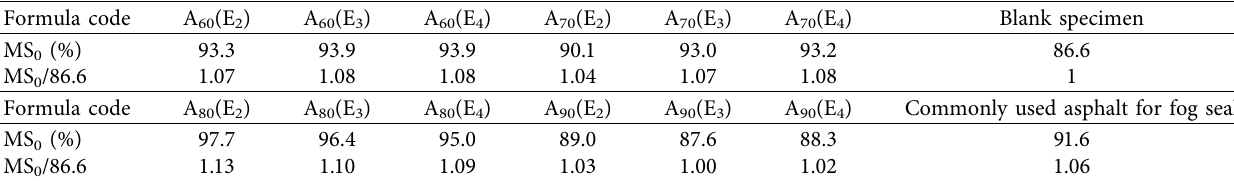
Figure 12: Cohesive shear strength of epoxy-emulsified Table 8: Immersion residual stability of fog seal Marshall specimens.